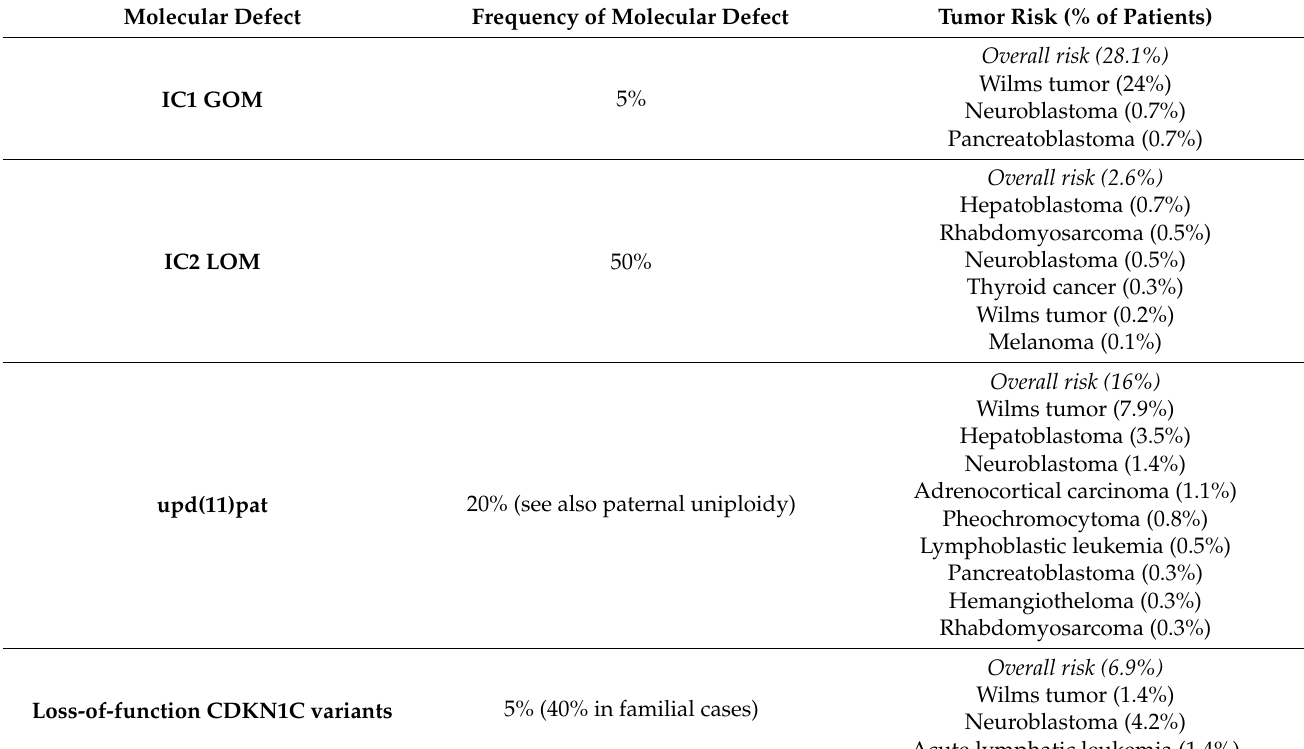
Table 2. Percentage of cancer risk for each molecular subgroup (according to